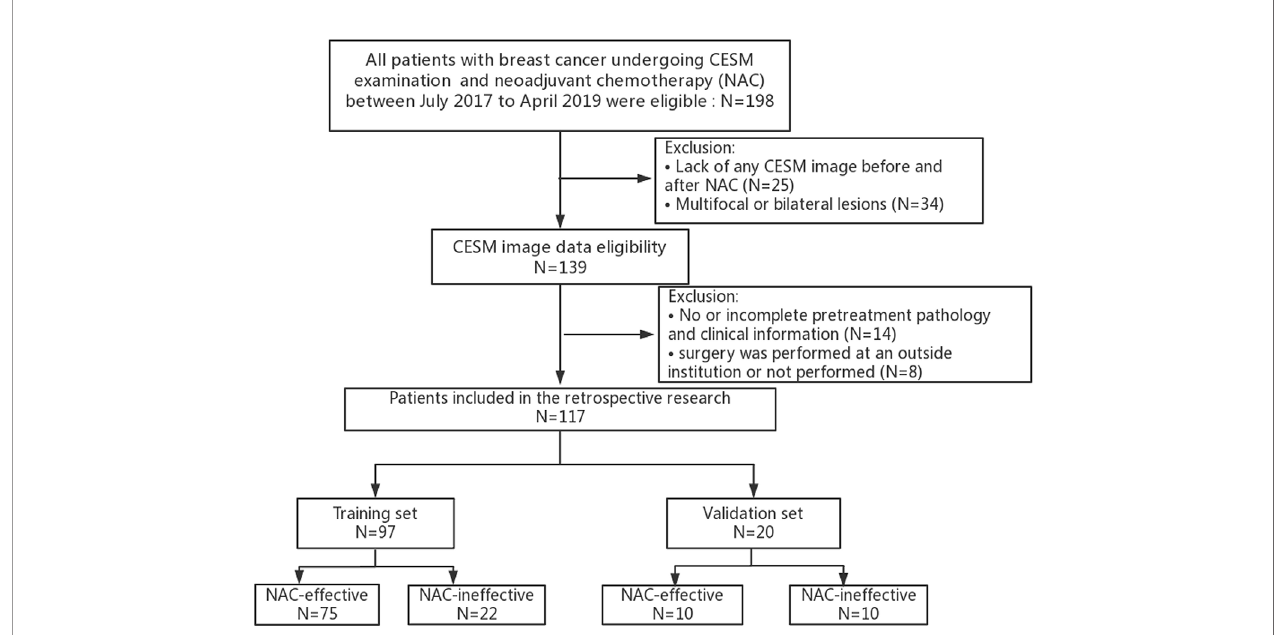
FIGURE 2 | Flow chart of the study population with exclusion